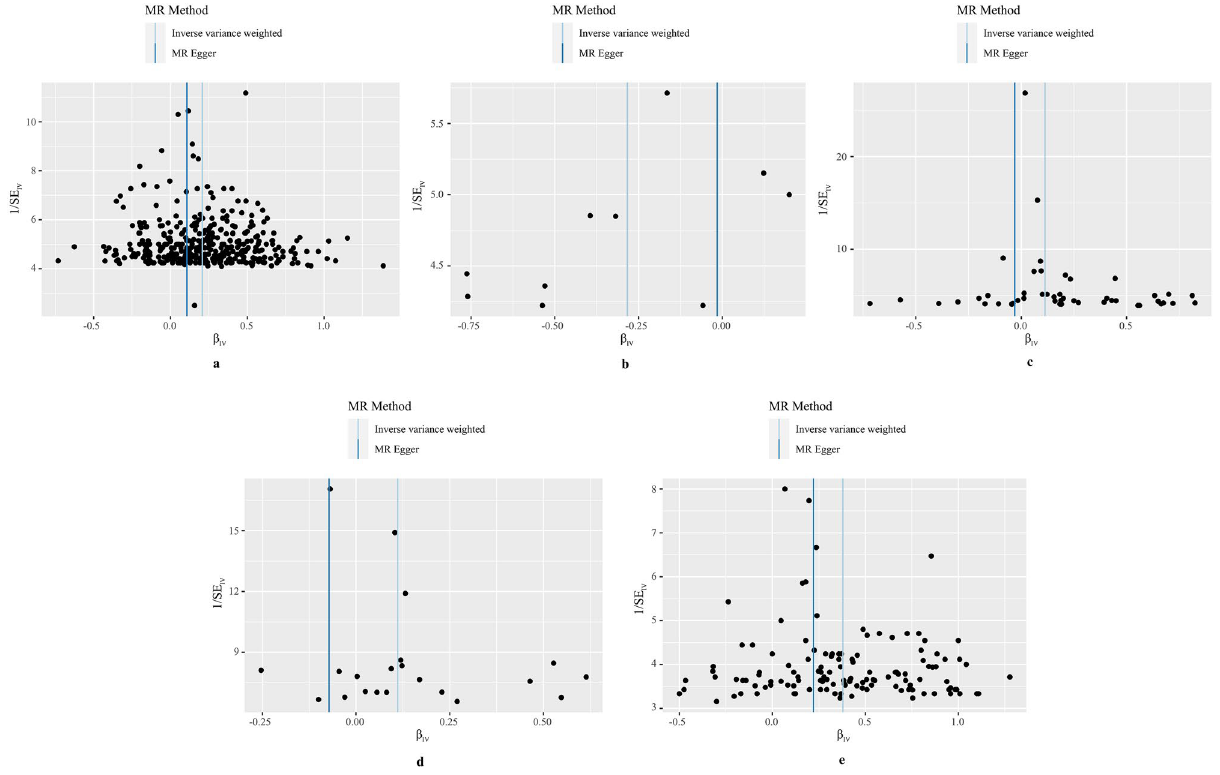
Figure 3. Funnel plots of MR analysis of five smoking phenotypes and frailty in ageing. ( a ) Smoking initiation (SmkInit); ( b ) age of initiation of regular smoking (AgeSmk); ( c ) cigarettes per day (CigDay); ( d ) smoking cessation (SmkCes); ( e ) lifetime